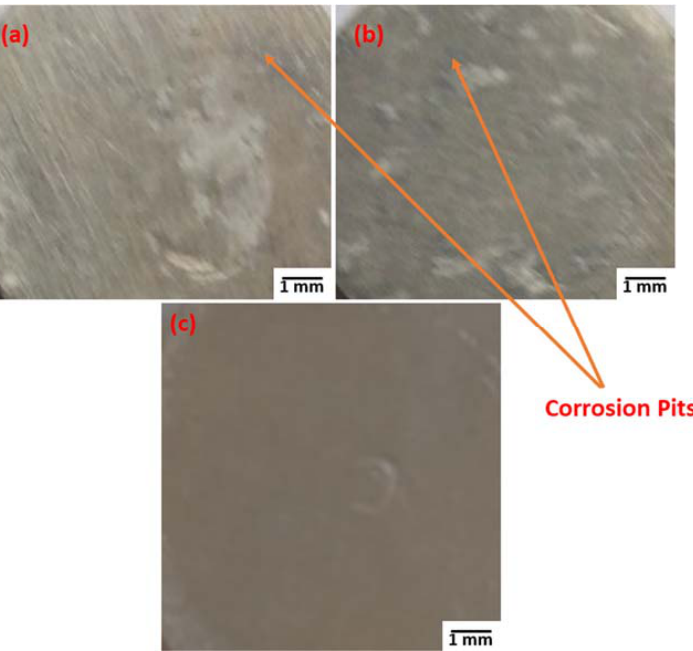
Figure 4. Corroded samples of ( a ) A9 and ( b ) A1 after immersion in NaCl solution for 15 days ( c ) uncorroded